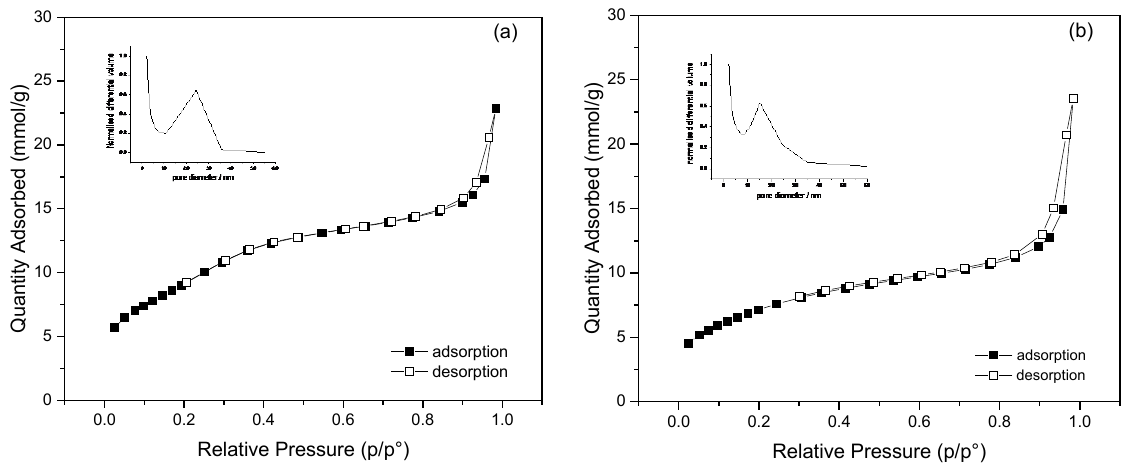
Figure 6. Nitrogen isotherms from MSiNPs ( a ) and MSiNP-DTC ( b ) and plots of the normalized differential volume as a function of pore diameter, as inset.